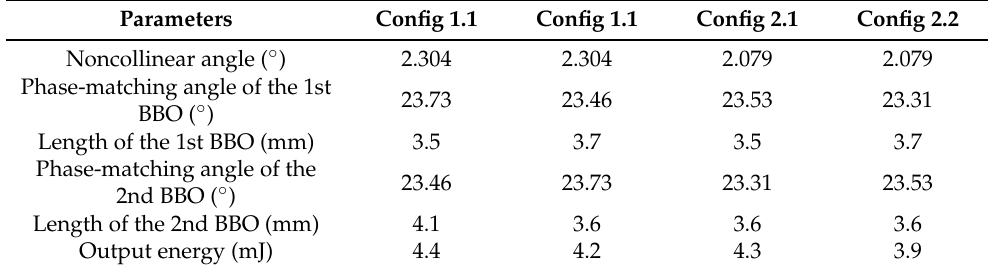
Figure 4. Compact double BBO arrangement. Table 1. Parameters of cascaded